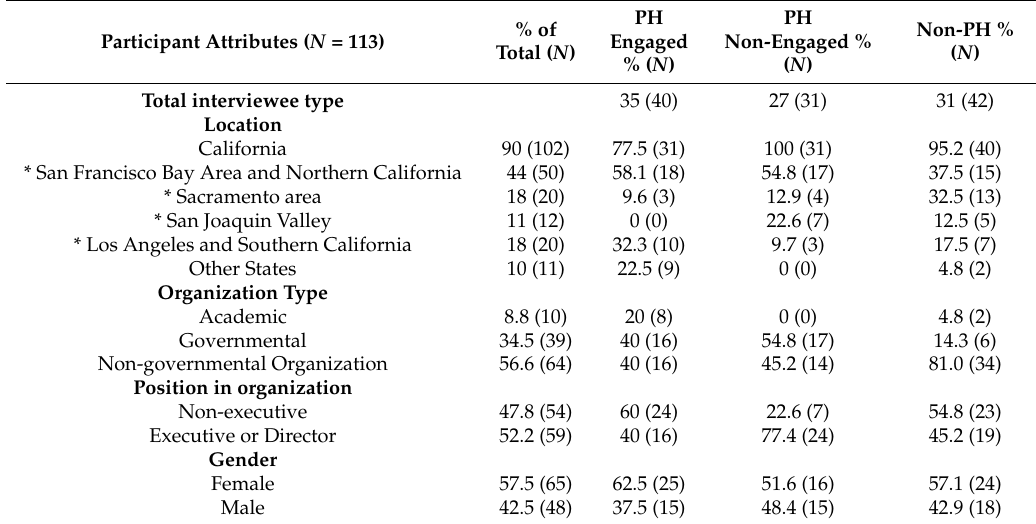
Table 2. Participant attributes by interviewee